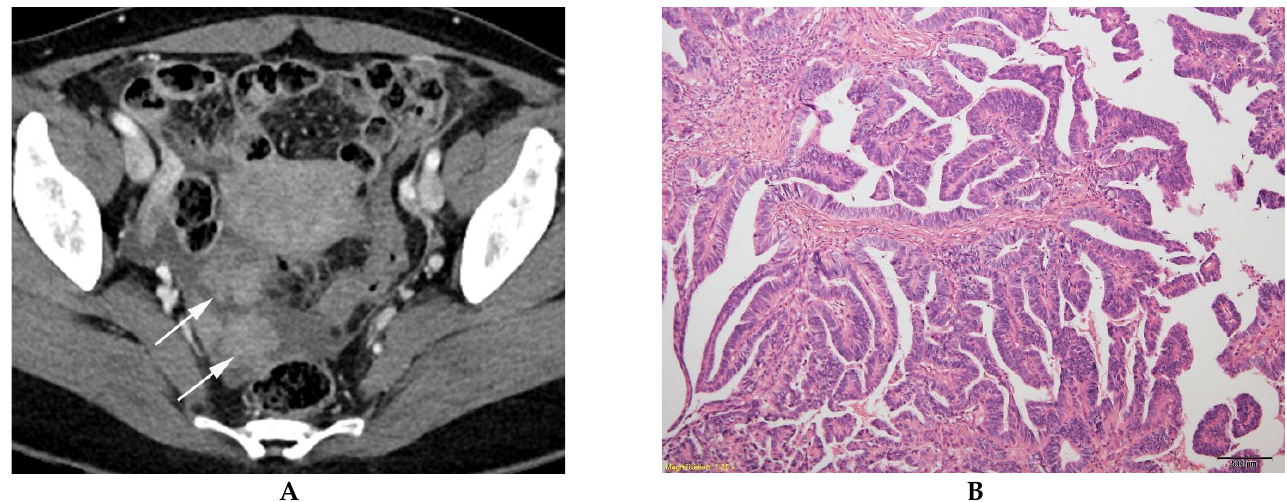
Figure 3. Serous ovarian carcinoma in a 44-year-old woman. ( A ) Contrast-enhanced axial CT shows a unilocular cystic mass with well-defined multiple solid components (arrows) in the right ovary. ( B ) A histologic section shows malignant glands of varying shapes and sizes infiltrating the stroma (hematoxylin and eosin 100×).